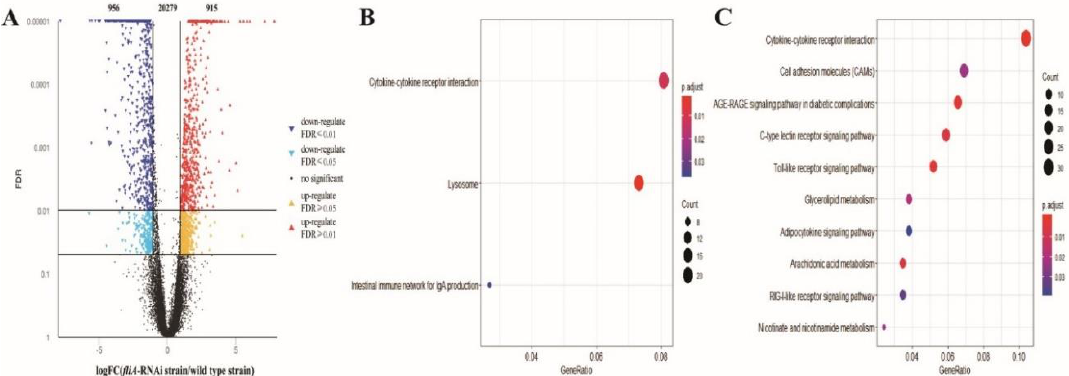
Figure 4. Global characterization of the host transcriptome in the spleen of L. crocea infected by P. plecoglossicida . ( A ) Volcano plot of all genes of the spleen. X-axis: the fold change values of genes of the fliA -RNAi strain infection group / wild type strain infection group. Y-axis: statistical test value (false discovery rate (FDR)), higher values represent more significant differences. Each dot represents a particular gene: red dots denote significantly upregulated genes, blue dots significantly downregulated genes and black dots genes with non-significant differences. ( B ) KEGG enrichment of upregulated genes. ( C ) KEGG enrichment of downregulated genes. In B and C, the X-axis shows the GeneRatio, whereby a higher value indicates more genes enriched in the pathway; the Y-axis shows the enriched pathways, and the more red the dot is, the more significant is the pathway.